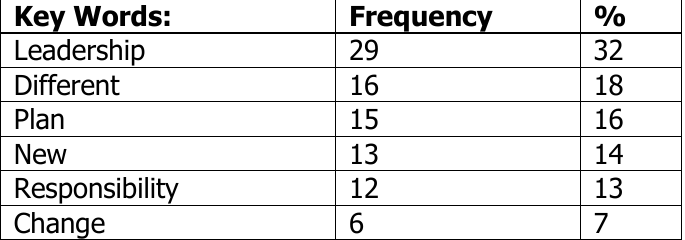
Content Analysis of Focus Group